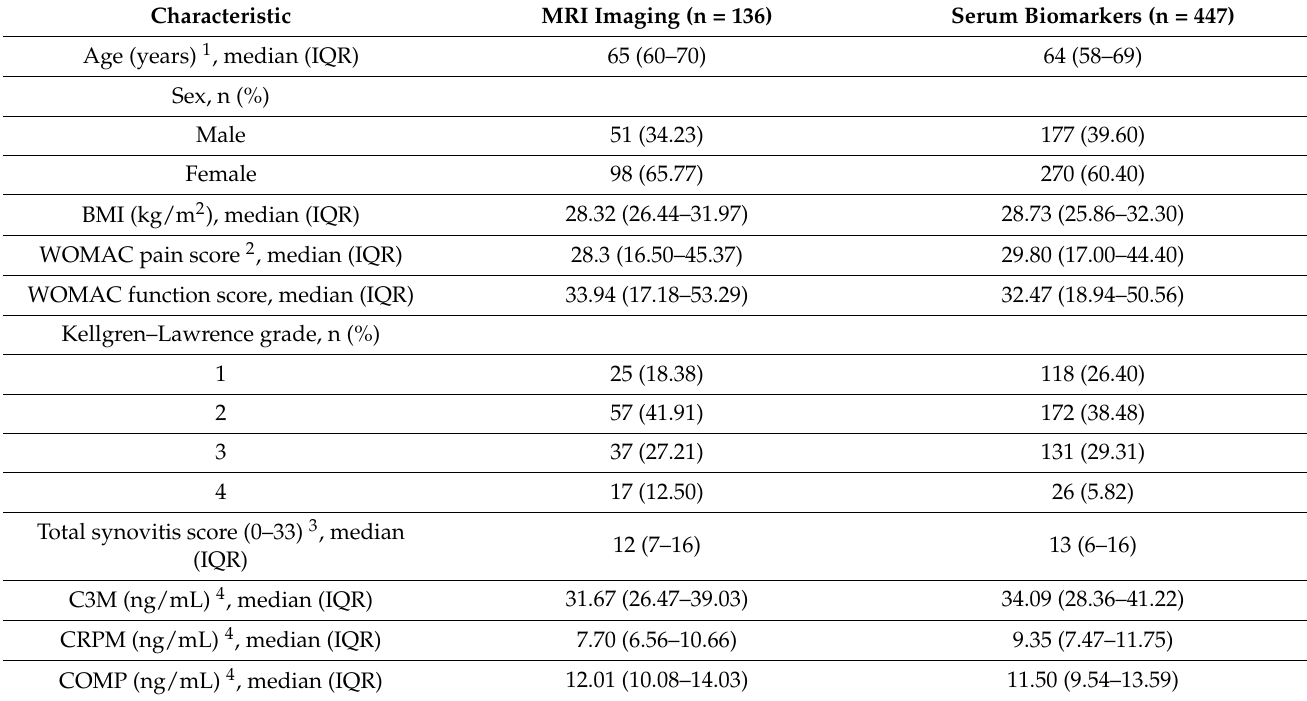
Figure 1. Flow chart of the study. Western Ontario and McMaster Universities Osteoarthritis Index (WOMAC), type III collagen degradation (C3M), metabolite of C-reactive protein (CRPM) and cartilage oligomeric matrix protein (COMP), Kellgren–Lawrence (KL). Table 1. Characteristics of study participants.